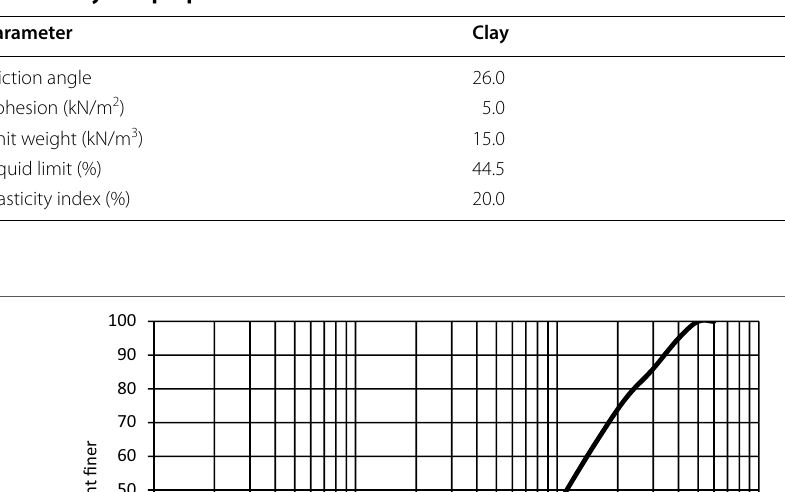
Table 1 Physical properties of the soils tested